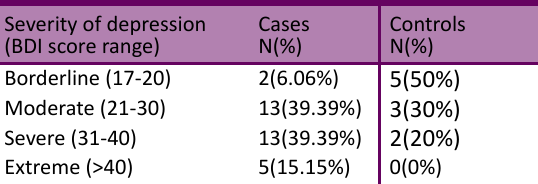
Table 1 – Severity of Depression according to BDI